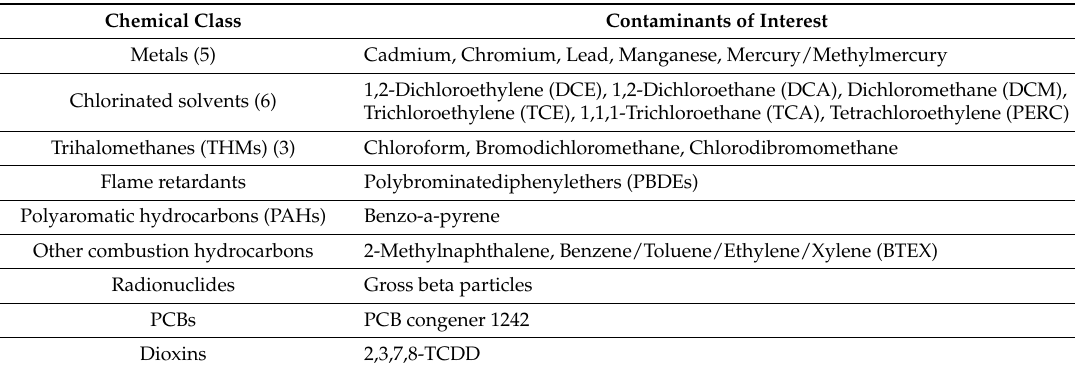
Table 4. Contaminants of interest identified from site profiles and secondary